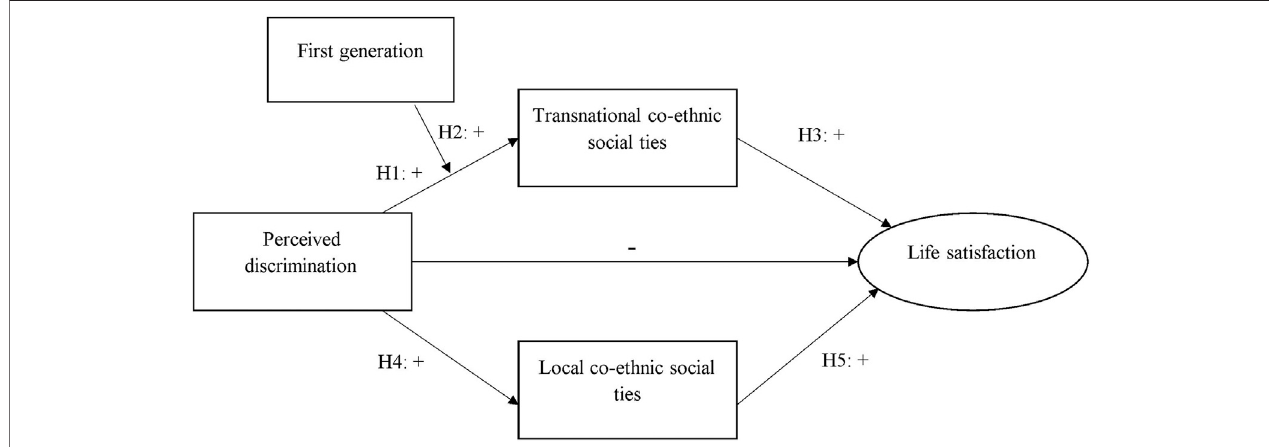
FIGURE 1 | Theoretical model. Control variables: Age, gender, employment, Dutch language skills, education, fi nancial dif fi culties, share of co-ethnic